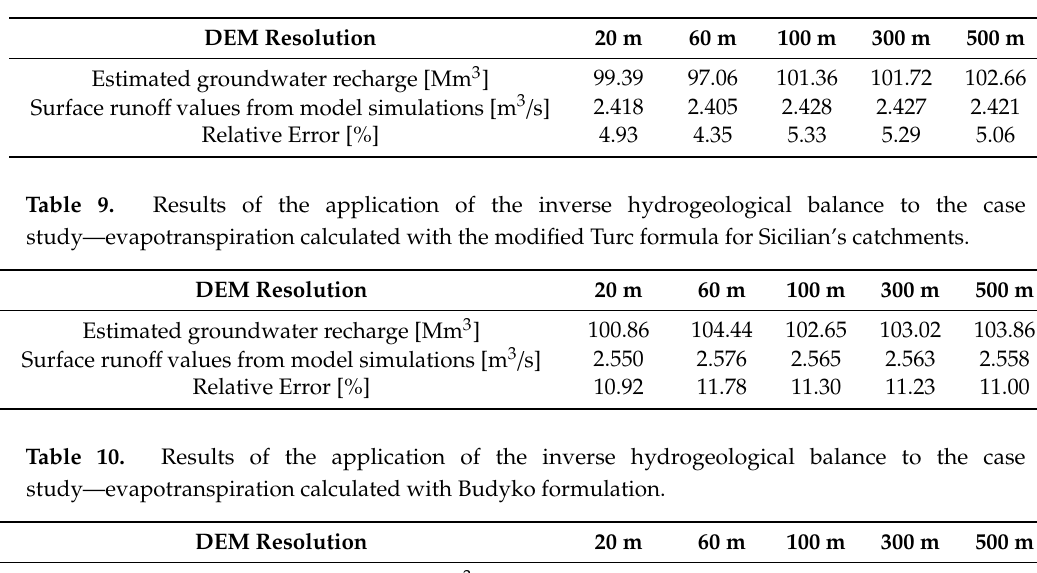
Results of the application of the inverse hydrogeological balance to the case study—evapotranspiration (ET) calculated with the classical Turc formula.